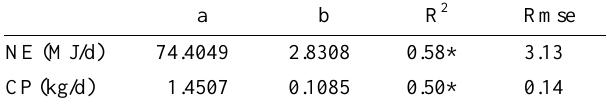
Table 3. Regression equations between intake of net energy or crude protein (y) and quantity of normalized milk produced (x)